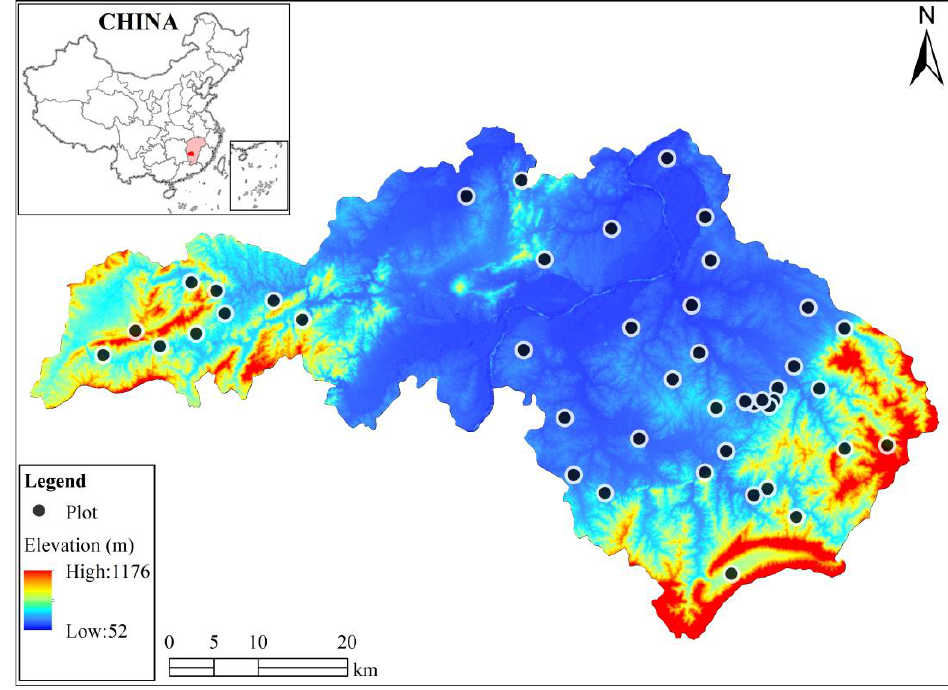
Figure 1. The geographical location of Taihe County and sampling plot distribution.